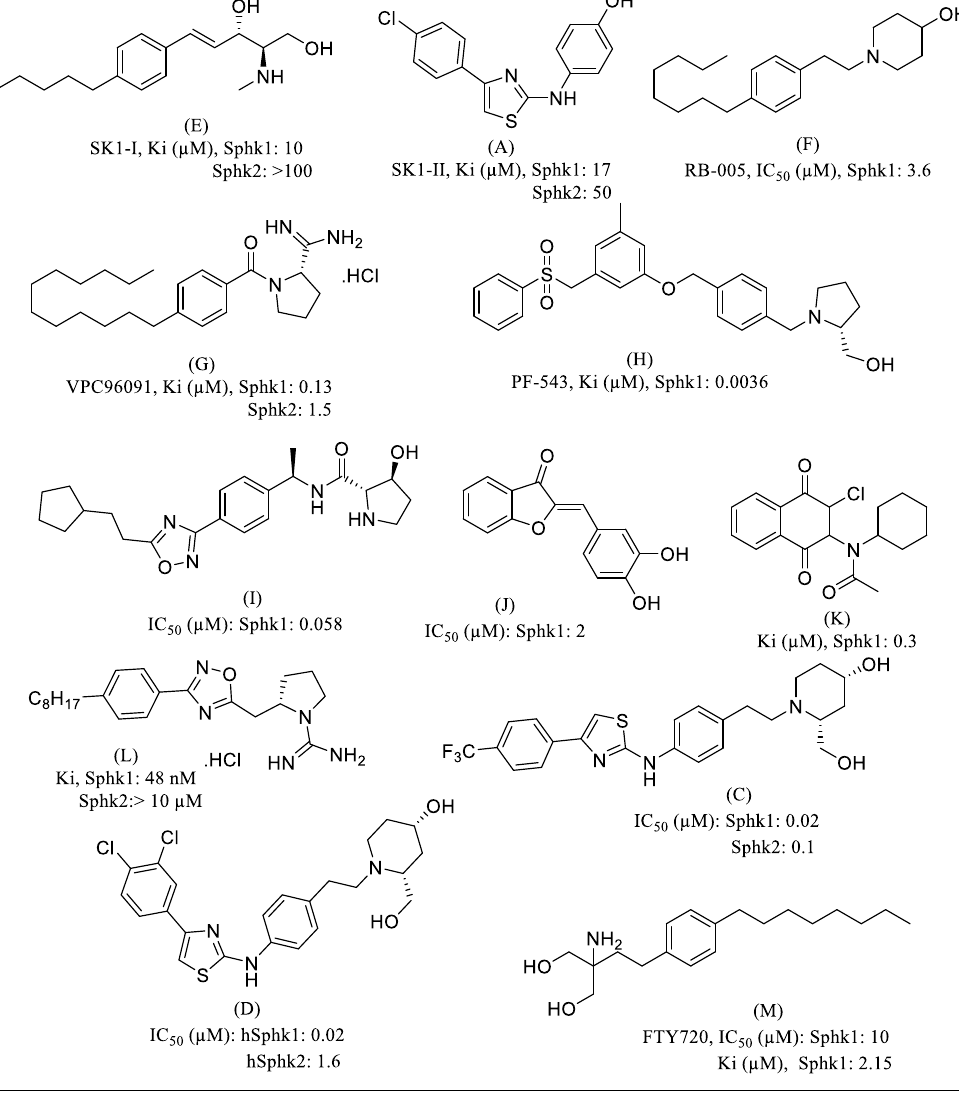
Figure 2. Major structural scaffolds reported as inhibitors of SphK1.